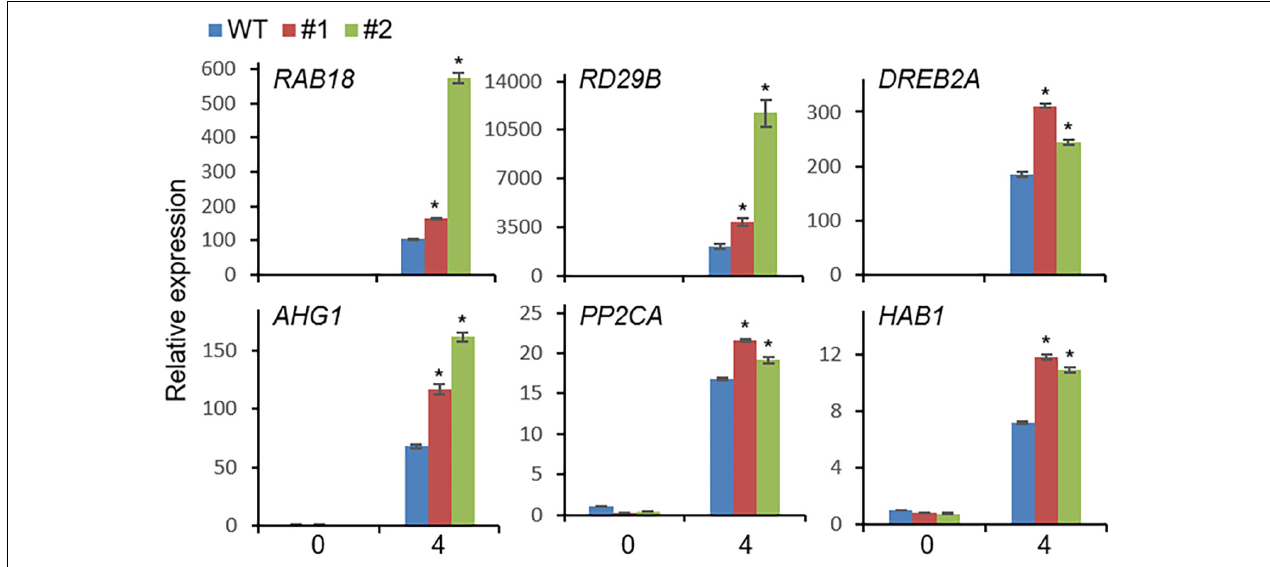
FIGURE 7 | qRT-PCR assay of stress-responsive genes in CaDIMK1 -overexpressing (OX) plants treated with drought stress at 0 and 4 h. The expression values are normalized to the Actin8 genes as an internal control. Values are mean ± SE, n = 3. Asterisks indicate statistical differences between wild-type and transgenic plants according to Student’s t -test (* P <